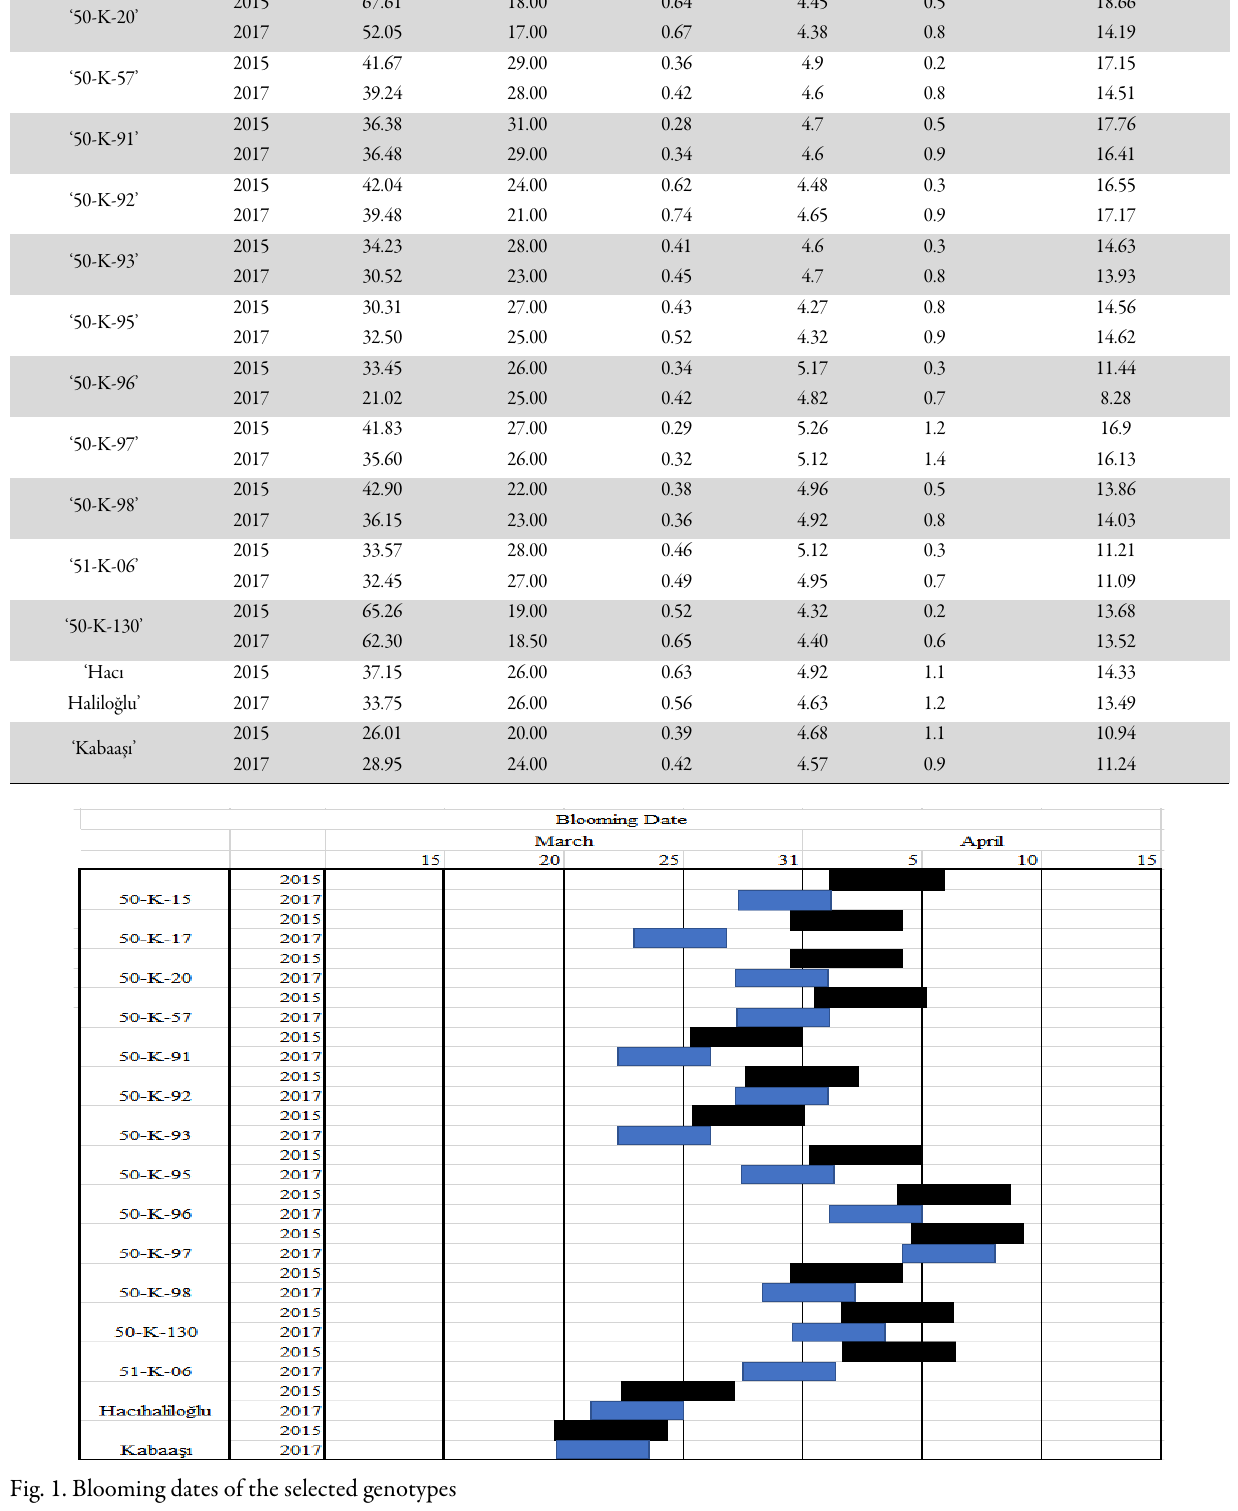
Fig. 1. Blooming dates of the selected